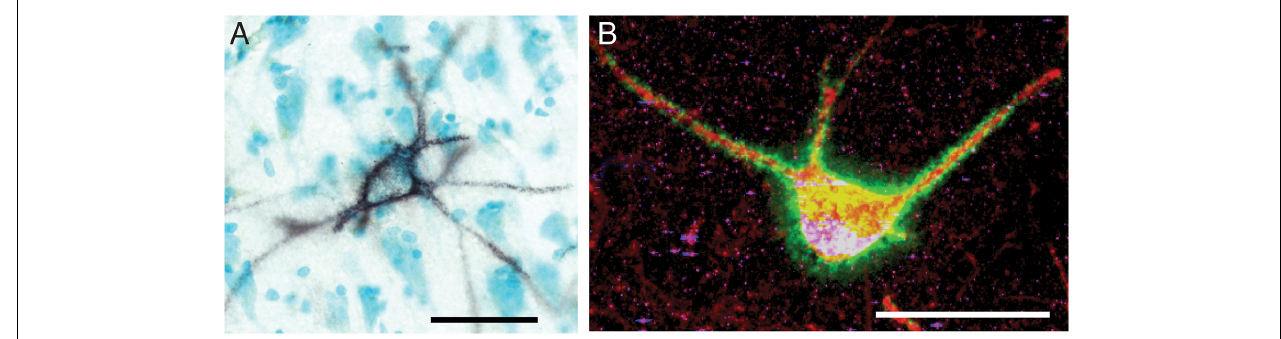
FIGURE 1 | Perineuronal nets in the human and mouse hippocampus. (A) Photomicrograph of a representative perineuronal net labeled by wisteria floribunda agglutinin in the human hippocampus. Cells are counterstained with methyl green according to previously published methods (Pantazopoulos et al., 2010b). (B) Confocal image of a perineuronal net in the mouse hippocampus labeled with wisteria floribunda agglutinin (green), surrounding a parvalbumin positive neuron (red) co-expressing synapsin-1 (blue). Scale bars = 50 µ